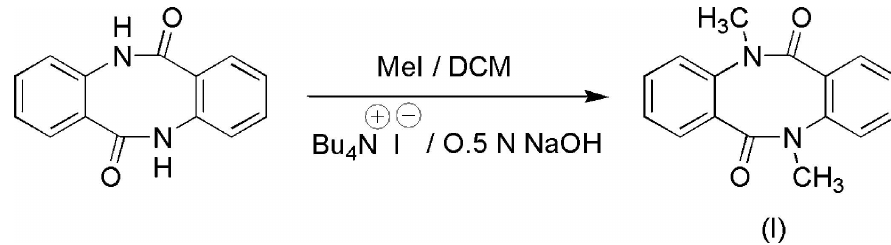
The molecular structure of the title molecule with the atom-numbering scheme. Displacement ellipsoids are drawn at the 50% probability level.